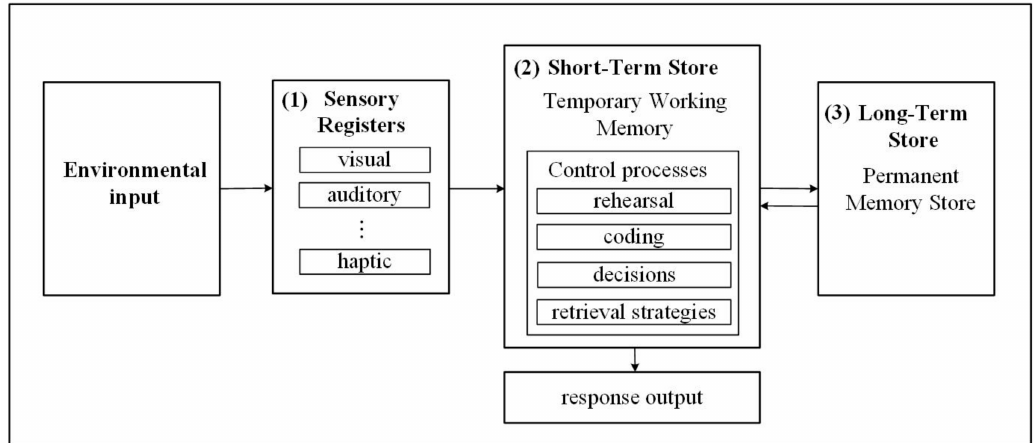
Figure 1. Information processing